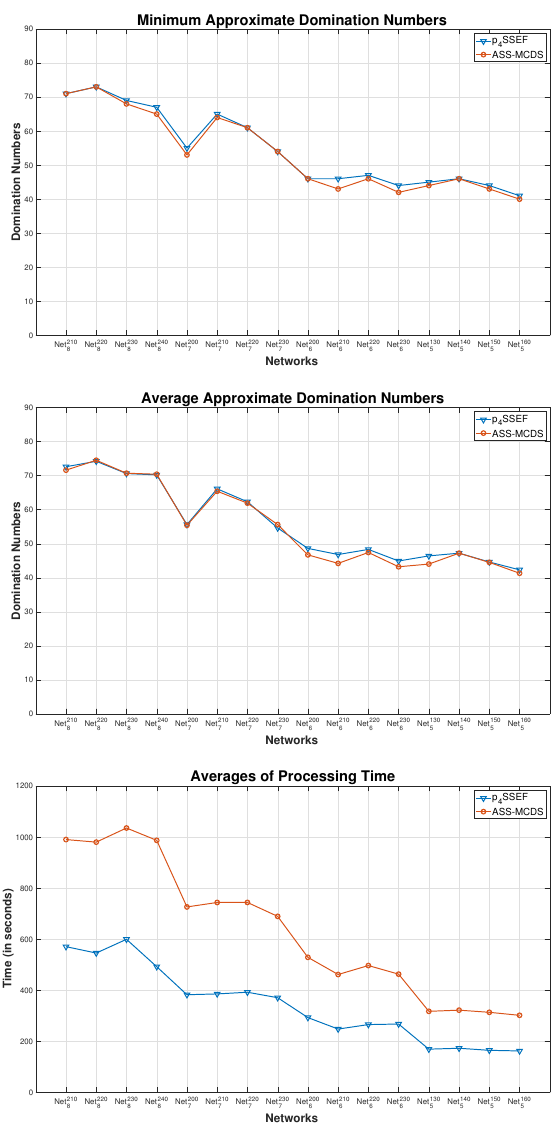
Figure 9. Metric comparisons between pSSEF and ASS-MCDS on big-size networks.